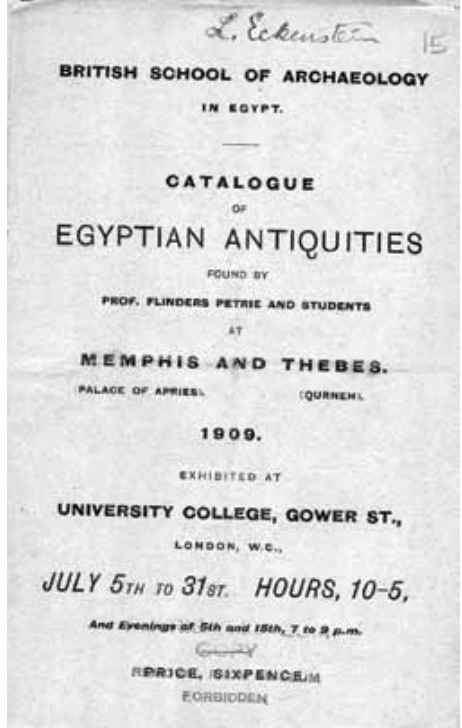
Fig. 2: The front cover of Flinders Petrie’s catalogue for the 1909 exhibition of his newly excavated finds from